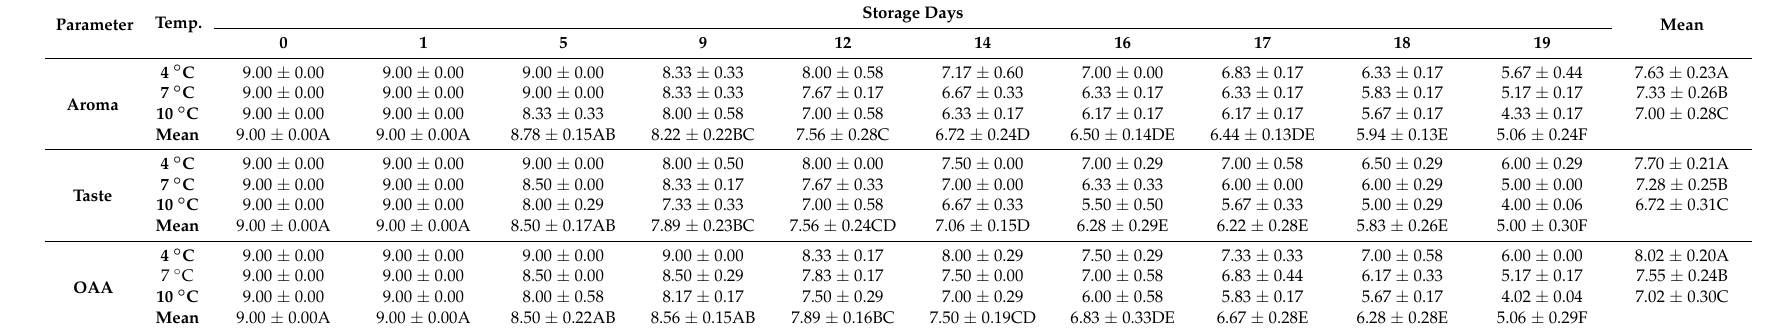
Table 5. Means values of score of sensory attributes of pasteurized milk stored at different temperatures. Parameter